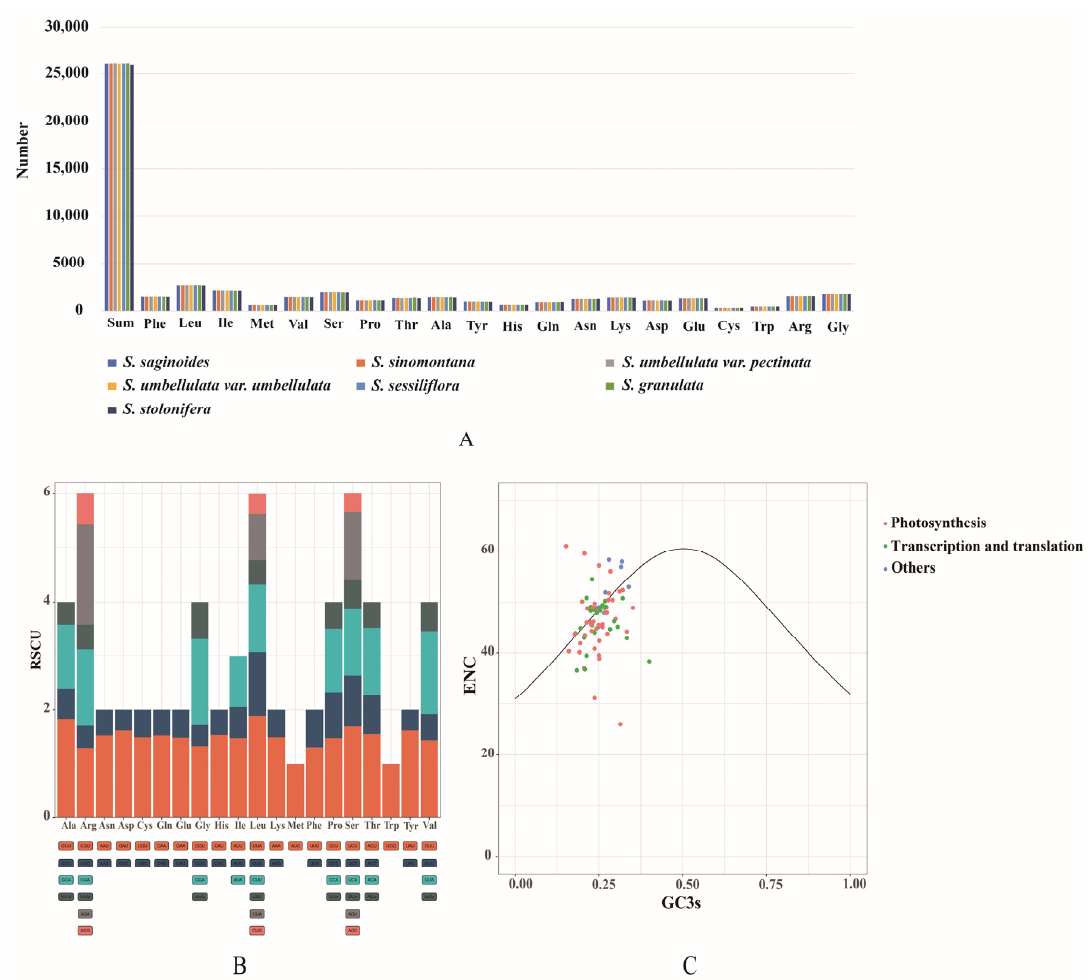
Figure 5. Usage preference of amino acids (AAs) and codons for PCGs. ( A ) AA usage of all the PCGs in each Saxifraga species. ( B ) RSCU for every AA in S. saginoides . For each amino acid, a color represents a unique codon. ( C ) ENC-GC3 plot for S. saginoides ; every gene was displayed as a dot, and different colors mean genes in distinct functional